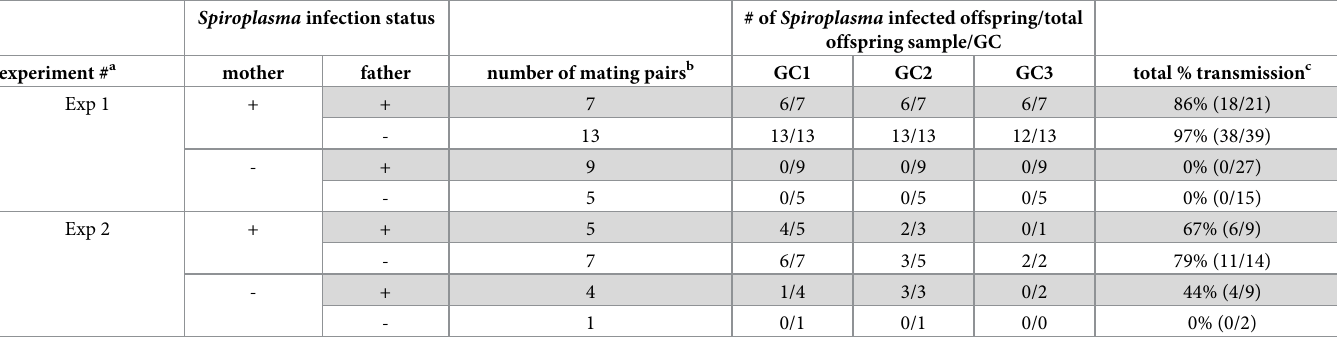
Table 1. Vertical transmission of Spiroplasma across three gonotrophic cycles (GCs). Spiroplasma infection